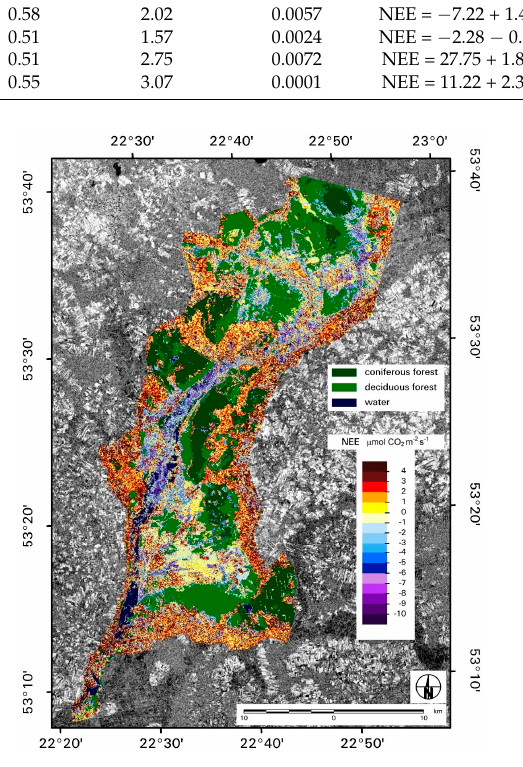
Figure 12. Map of NEE distribution over Biebrza wetland on 11 June 2015.